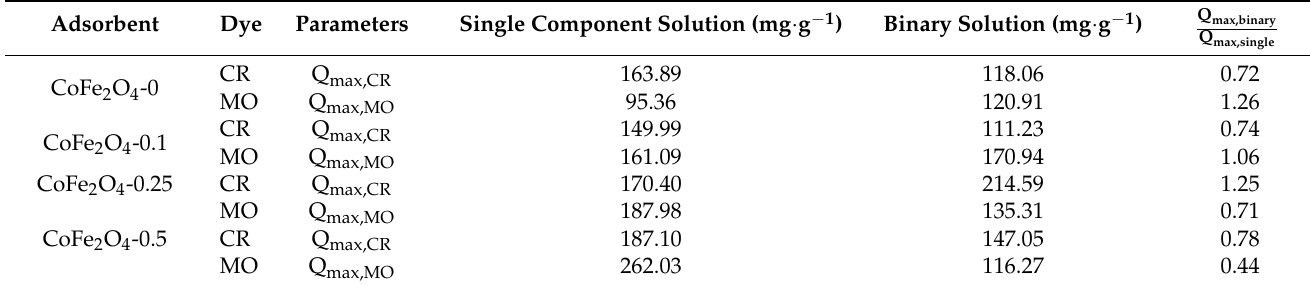
Table 8. Maximum adsorption capacity calculated using Langmuir and modified Langmuir isotherm models for single component and binary